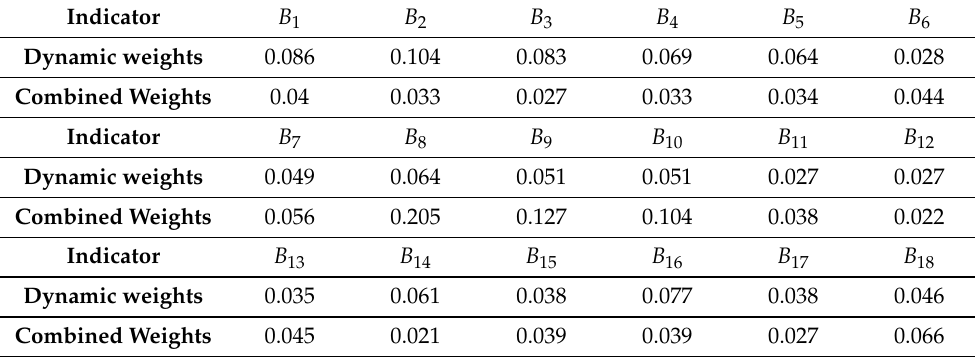
Table 8. Final weight